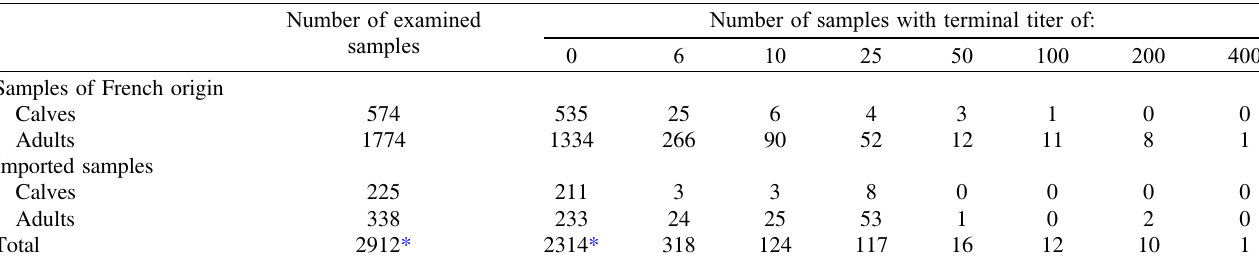
Table 1. Results of the modi fi ed agglutination test (MAT) accordingly to the origin of samples (French/imported), age of animals (calves/ adults) and terminal titer.